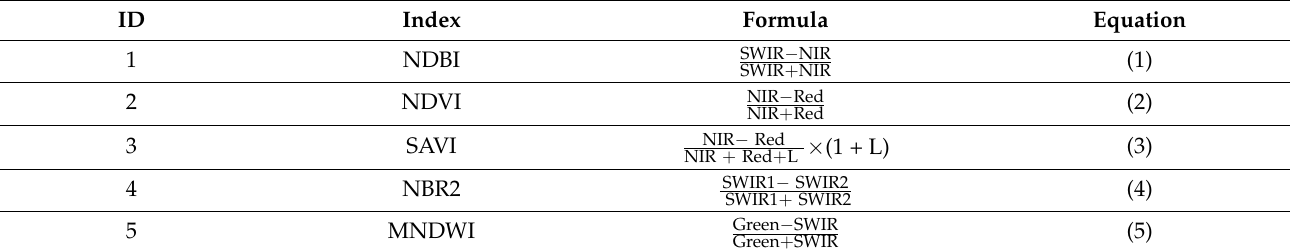
Table 2. Summary of spectral indices used for LULC